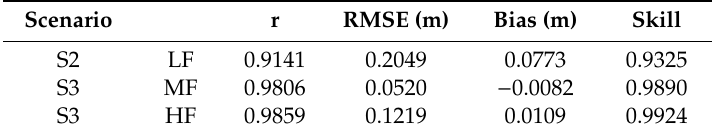
Table 7. Error metrics for the water level at station VP5 for scenarios S2 and S3.